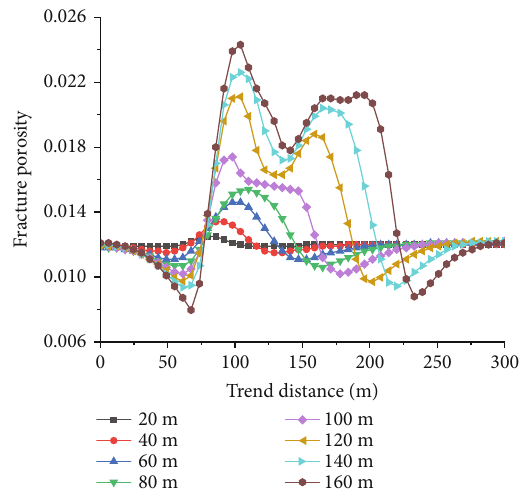
Figure 12: Fracture porosity evolutions of protected layer at varying advancing